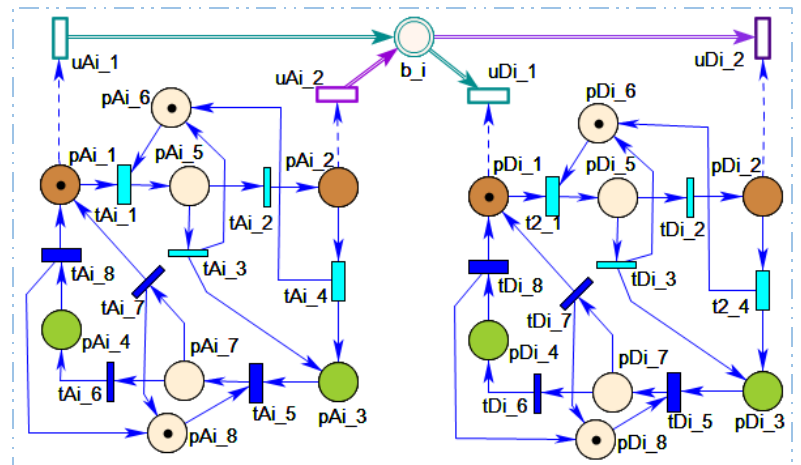
FSHPN 1 оf a dipоle DP оf 1 FSHPN shоwn in figure 5. i i